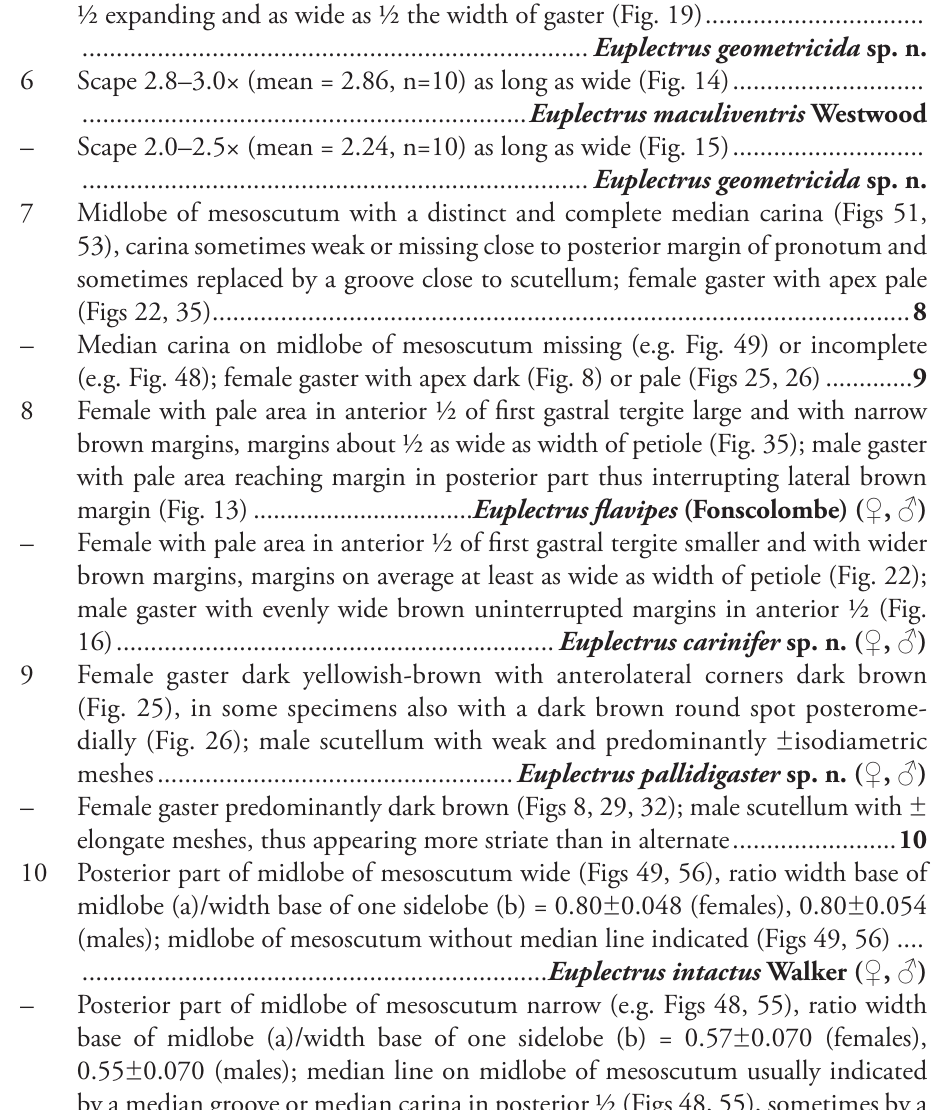
Scape 2.8–3.0× (mean = 2.86, n=10) as long as wide (Fig. 14) ............................ – Scape 2.0–2.5× (mean = 2.24, n=10) as long as wide (Fig. 15) ............................ 7 Midlobe of mesoscutum with a distinct and complete median carina (Figs 51, 53), carina sometimes weak or missing close to posterior margin of pronotum and sometimes replaced by a groove close to scutellum; female gaster with apex pale (Figs 22, 35) ...................................................................................................... 8 – Median carina on midlobe of mesoscutum missing (e.g. Fig. 49) or incomplete (e.g. Fig. 48); female gaster with apex dark (Fig. 8) or pale (Figs 25, 26) ............. 9 8 Female with pale area in anterior ½ of first gastral tergite large and with narrow brown margins, margins about ½ as wide as width of petiole (Fig. 35); male gaster with pale area reaching margin in posterior part thus interrupting lateral brown margin (Fig. 13) ................................. Euplectrus flavipes (Fonscolombe) ( ♀ , ♂ ) – Female with pale area in anterior ½ of first gastral tergite smaller and with wider brown margins, margins on average at least as wide as width of petiole (Fig. 22); male gaster with evenly wide brown uninterrupted margins in anterior ½ (Fig. 16) ................................................................ Euplectrus carinifer sp. n. ( ♀ , ♂ ) 9 Female gaster dark yellowish-brown with anterolateral corners dark brown (Fig. 25), in some specimens also with a dark brown round spot posterome- dially (Fig. 26); male scutellum with weak and predominantly ± isodiametric meshes .................................................... Euplectrus pallidigaster sp. n. ( ♀ , ♂ ) – Female gaster predominantly dark brown (Figs 8, 29, 32); male scutellum with ± elongate meshes, thus appearing more striate than in alternate ........................ 10 10 Posterior part of midlobe of mesoscutum wide (Figs 49, 56), ratio width base of midlobe (a)/width base of one sidelobe (b) = 0.80 ± 0.048 (females), 0.80 ± 0.054 (males); midlobe of mesoscutum without median line indicated (Figs 49, 56) .... – Posterior part of midlobe of mesoscutum narrow (e.g. Figs 48, 55), ratio width base of midlobe (a)/width base of one sidelobe (b) = 0.57 ± 0.070 (females), 0.55 ± 0.070 (males); median line on midlobe of mesoscutum usually indicated by a median groove or median carina in posterior ½ (Figs 48, 55), sometimes by a weak carina in anterior ½, in some specimens median line indicated just through a change in the reticulation ............................................................................. 11 11 Female with pale area on lower frons with upper-lateral part drawn out towards eye and almost reaches eye (Fig. 30); scutellum with isodiametric meshes (Fig. 50) (males key out under couplet 6) ................ Euplectrus maculiventris Westwood – Female with pale area on lower frons not drawn out laterally (Fig. 10), scutellum with elongate or isodiametric meshes, or males ...............................................